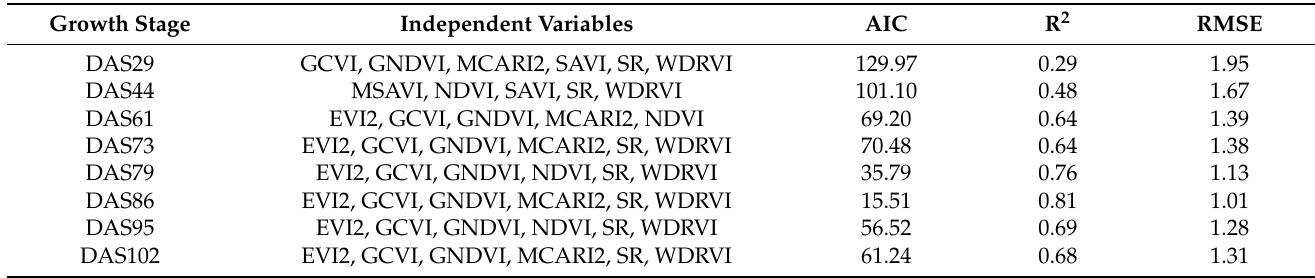
Table 4. The accuracy of the PlanetScope-based Yield-SMLR model in each growth period.